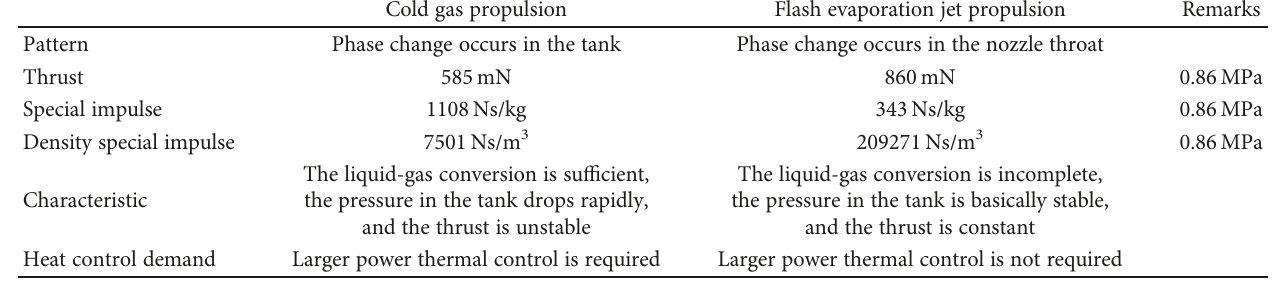
Table 1: Propulsive performances of cold gas propulsion and fl ash evaporation jet propulsion [48].